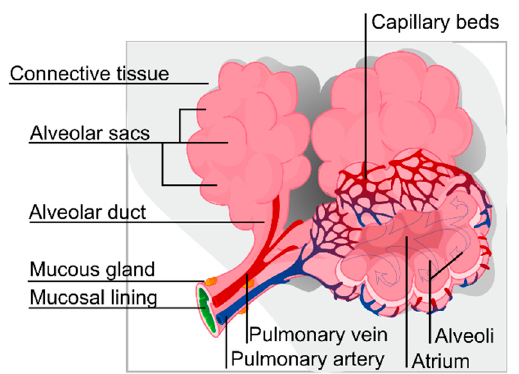
Figure 1. A depiction of human alveoli, bronchioles, and blood vessels facilitating gas exchange. Here, the alveoli are analogous to our fin and the blood vessels are analogous to the thermal medium. Image credit: https://en.wikipedia.org/wiki/Pulmonary_alveolus (accessed on 16 October 2022).